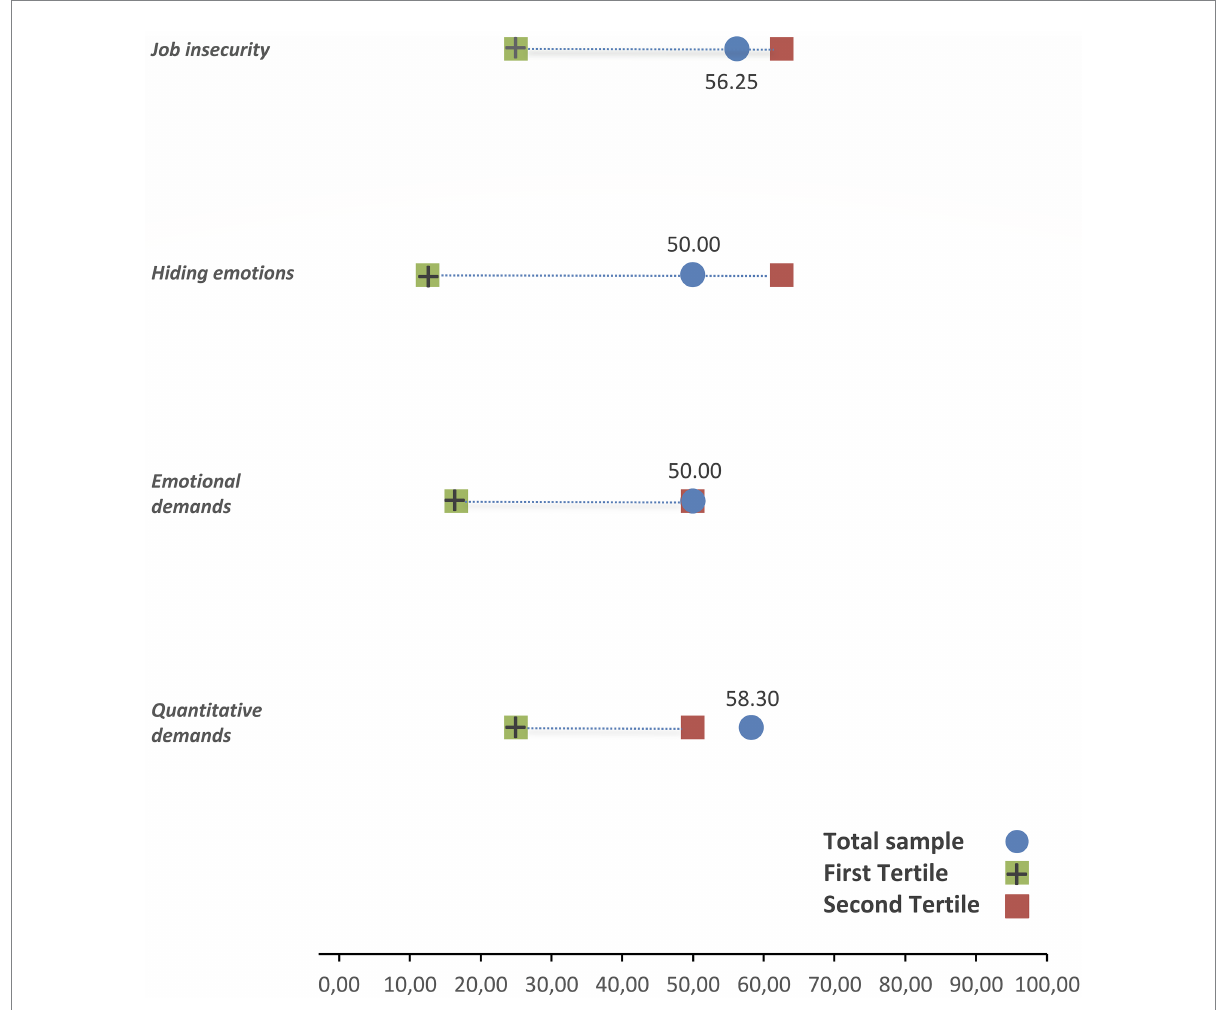
FIGURE 4 Description of the negative psychosocial